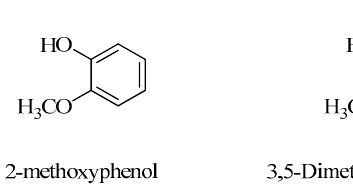
Figure 2. Three major components of the wood vinegar. Table 1. Chemical constituents of the wood vinegar analyzed by GC-MS.